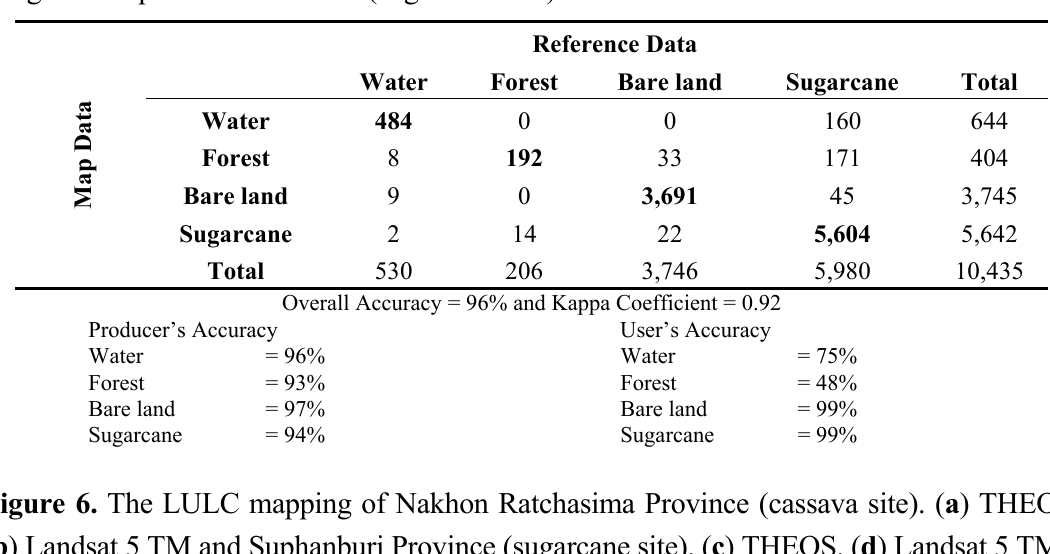
Table 12. Error matrix of LULC classification accuracy assessment for Landsat 5 TM images of Suphanburi Province (sugarcane site).